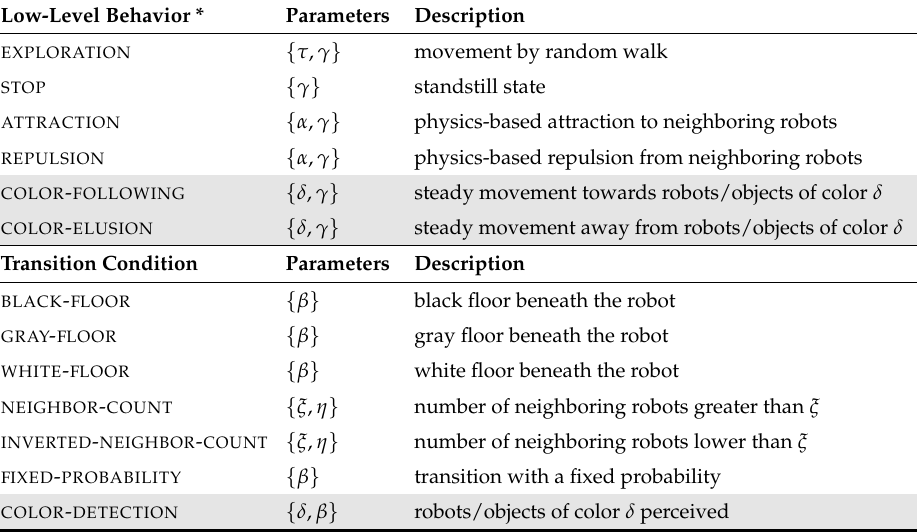
Table 2. Set of TuttiFrutti ’s modules. Novelties with respect to Vanilla are highlighted in gray. They concern to the capability of acting upon perceived colors. The modules operate according to RM3, see Table